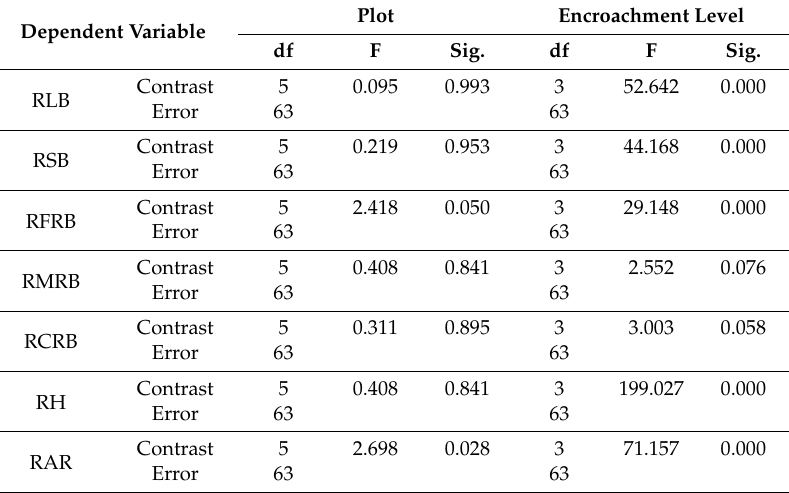
Table 2. The F tests the effect of the plot and of the encroachment level of R. aureum biomass, height, and leaf area.